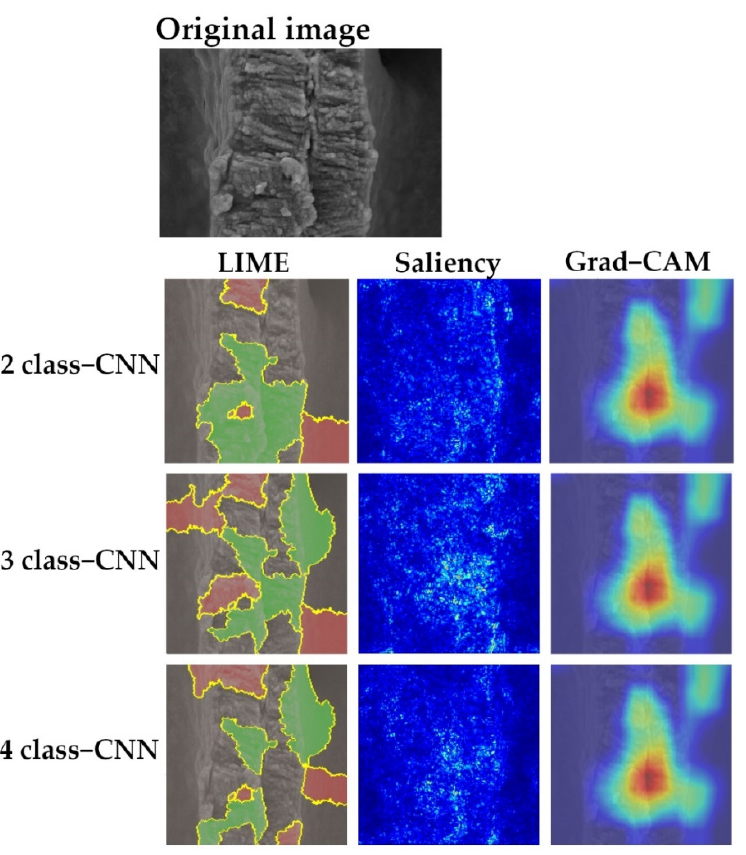
Figure 5. An example of the output obtained from the three approaches (LIME, Saliency, Grad-CAM) that show the pixels giving the major contributions to the CNN classification in the different models used (2, 3 and 4 class-CNNs). In LIME, positive and negative contributions to classification are respectively colored in green and red. In Saliency, brighter color highlights the pixels contributing the most to the class attribution, while in the Grad-CAM visualization the most significant areas for the final classification have a warmer color tone. The SEM image was successfully classified as Lithothamnion corallioides by every model and shows a magnification of the cell wall ultrastructure (crystallites category).